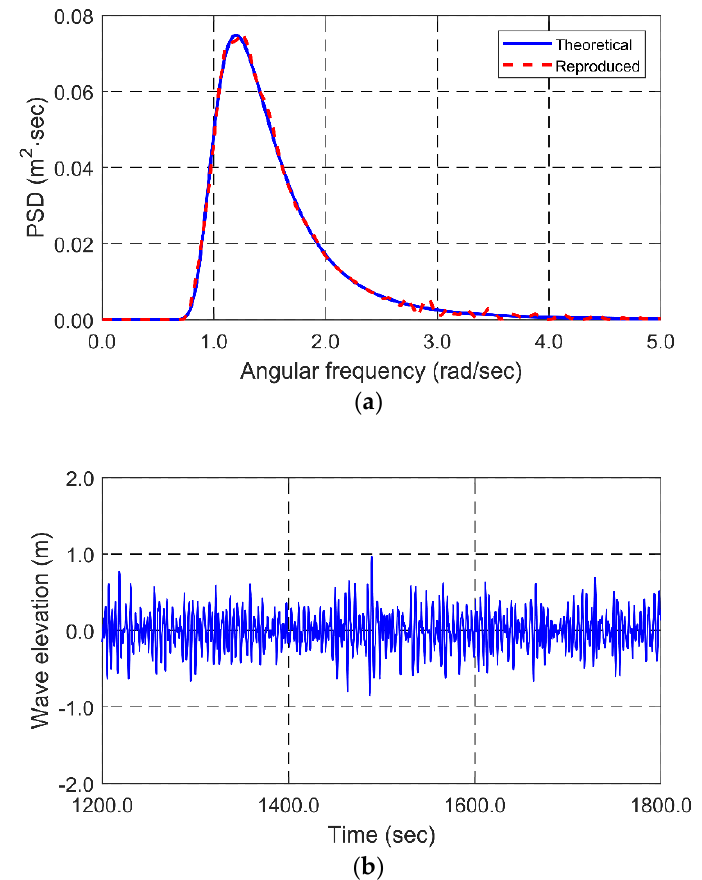
Figure 3. Theoretical JONSWAP wave spectrum and reproduced spectrum from wave time histories using FFT ( a ) and wave time histories generated from JONSWAP wave spectrum ( b ) for H s = 1.0 m, T p = 5.25